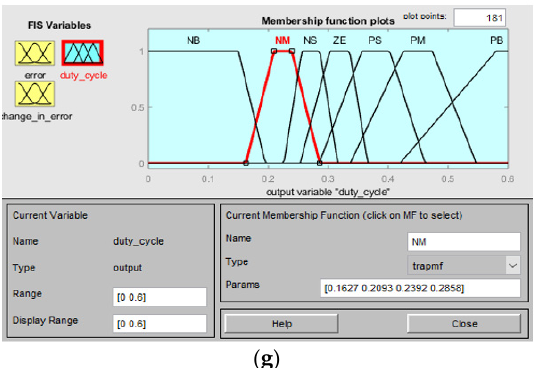
Figure 7. ( a ) Fuzzy design, triangular MFs of ( b ) E (k) ( c ) DE (k) ( d ) duty cycle; Trapezoidal MFs of ( e ) E (k) ( f ) DE (k) ( g ) duty cycle.